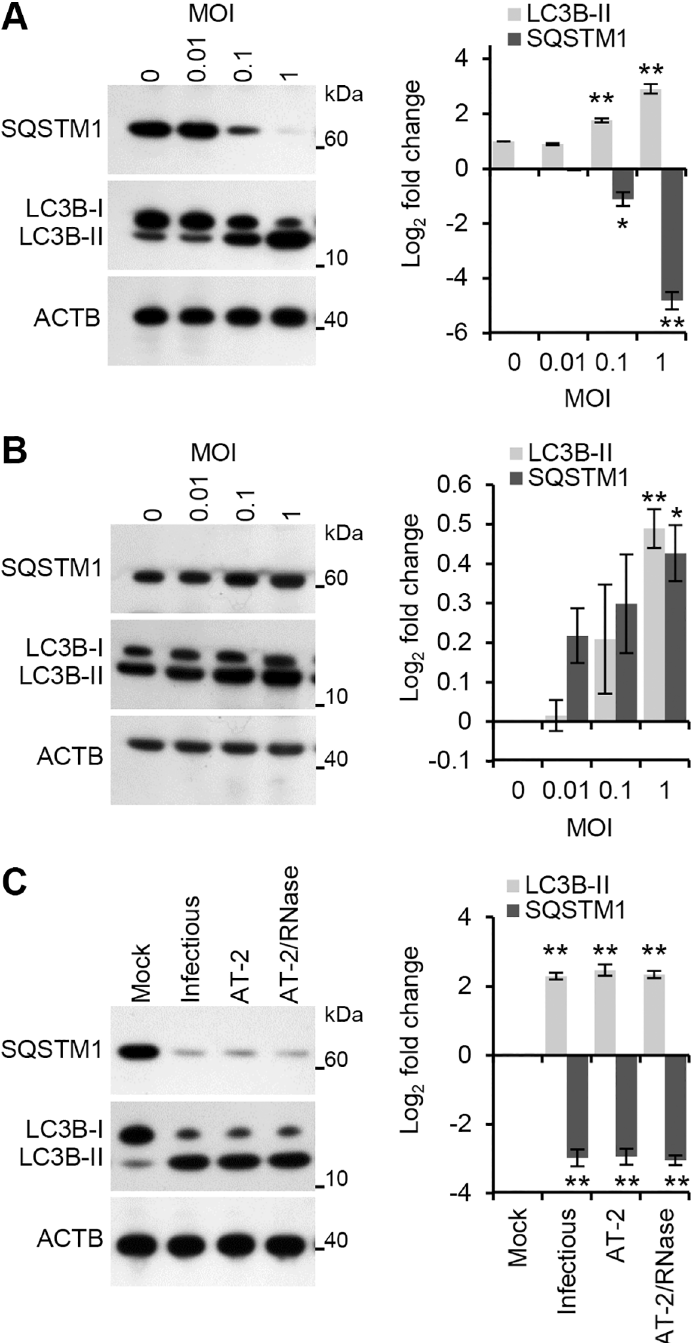
Fig 1. HIV induces autophagy in human macrophages. (A) Macrophages were exposed to increasing concentrations of cell-free RNase/DNase I treated iodixanol velocity gradient purified HIV for 24 h, harvested, lysed and analyzed for endogenous LC3B, SQSTM1, and ACTB by Western blotting. Left , a representative blot is shown. Right , densitometric analysis of immunoblots from independent donors presented as means ± s.e.m., n = 3. (B) Macrophages were exposed to increasing concentrations of cell-free RNase/ DNase I treated iodixanol velocity gradient purified HIV for 24 h in the presence of pepstatin A, harvested, lysed and analyzed for endogenous LC3B, SQSTM1, and ACTB by Western blotting. Left , a representative blot is shown. Right , densitometric analysis of immunoblots from independent donors presented as means ± s.e.m., n = 3. (C) Macrophages were exposed to mock, infectious, AT-2-inactivated, or RNase/